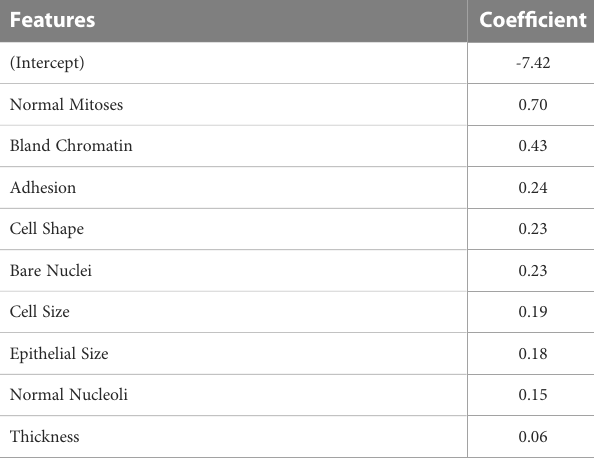
TABLE 1 Coef fi cients for the generalized linear model (GLM) with regularization.